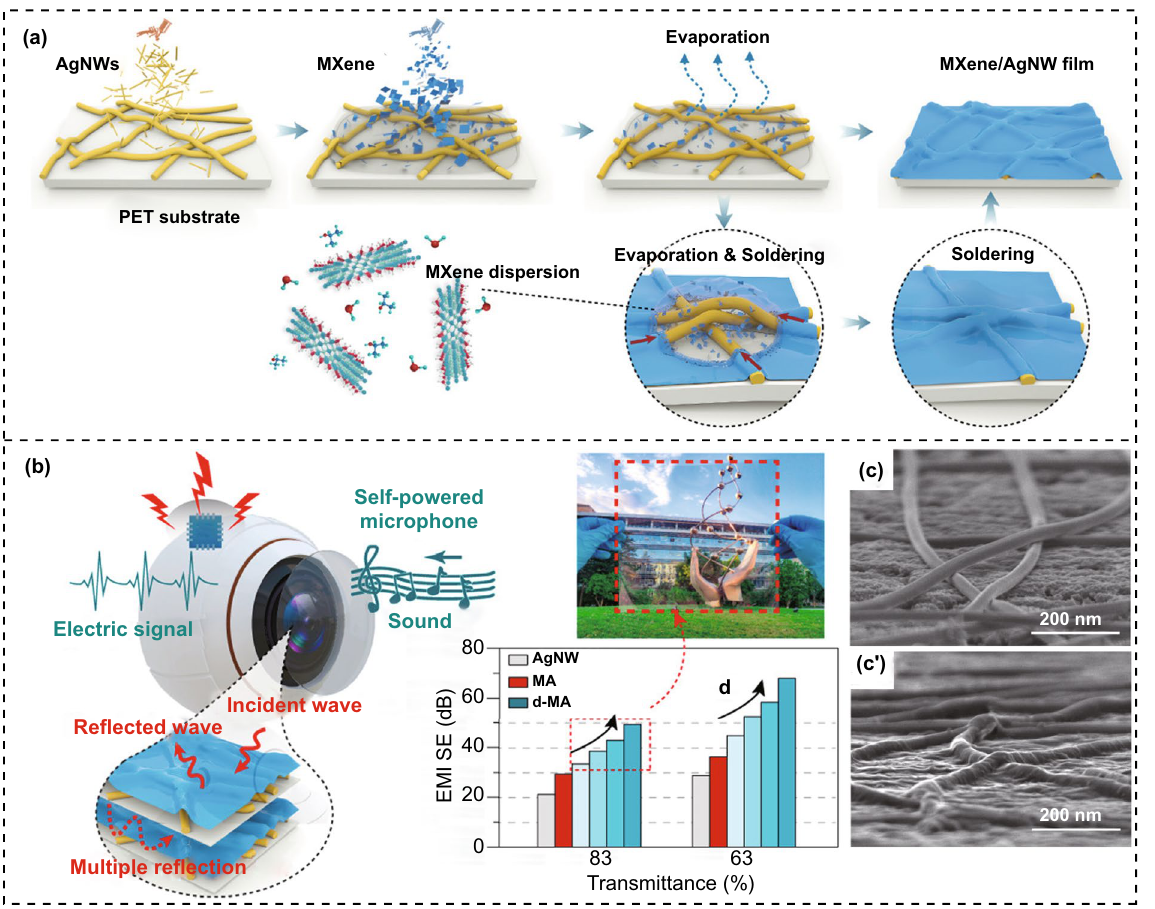
Fig. 13 a Schematic illustrating the fabrication, b EMI SE, and c SEM images of MXene/AgNW/PET composite films [140]. Copyright © 2020 American Chemical